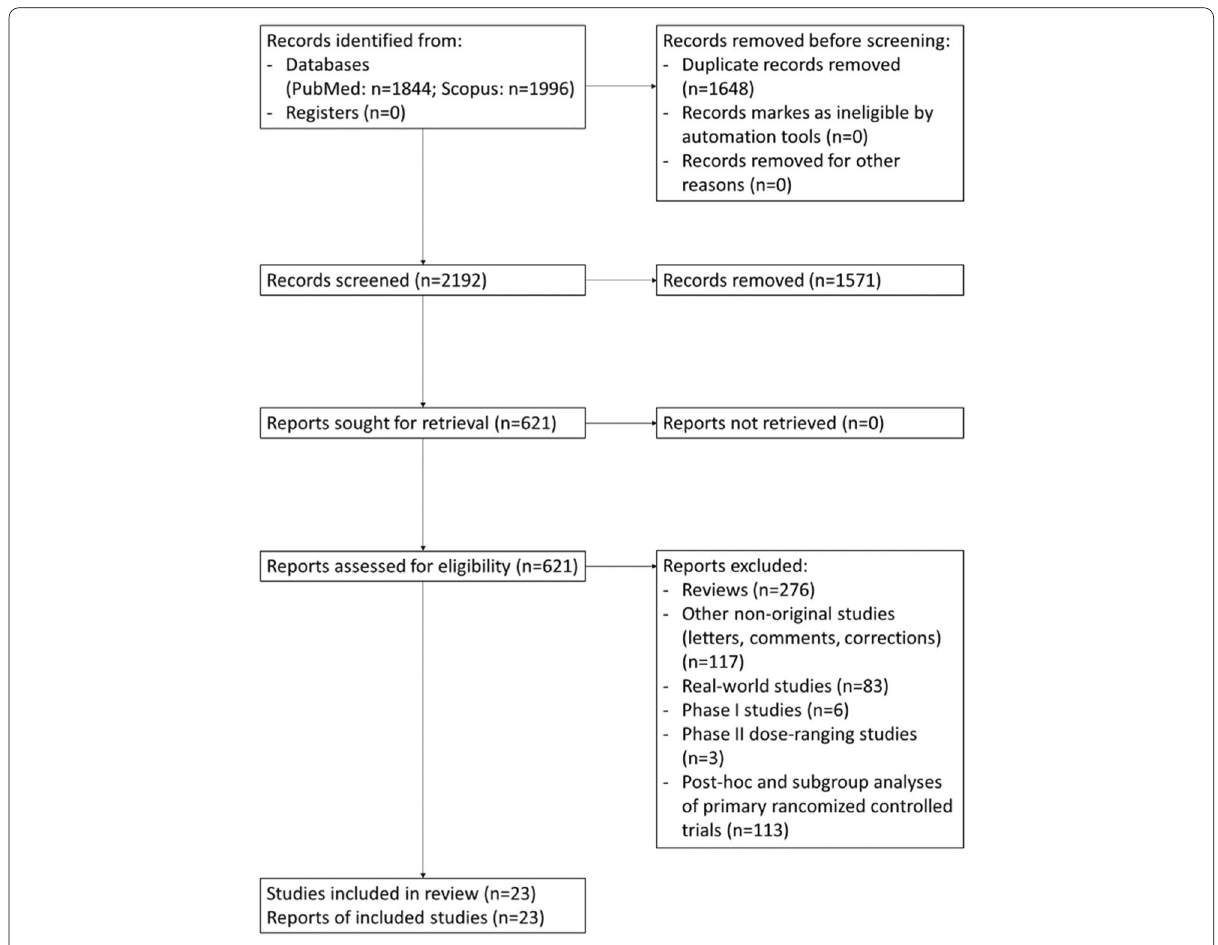
Fig. 1 PRISMA Flowchart of study